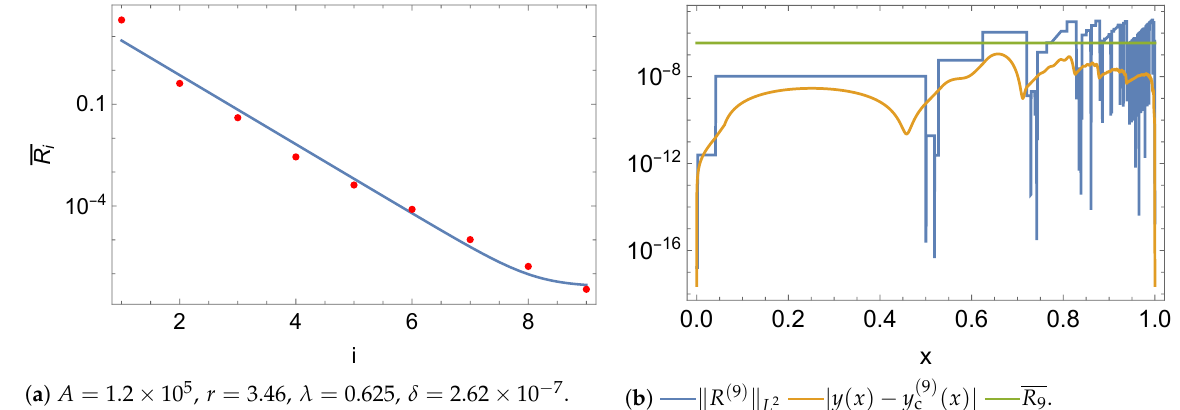
Figure 13. ( a ) The approximating polynomial y ( b ) Plot of the statistic ω i . ( ) ω i ≈ 0.62.